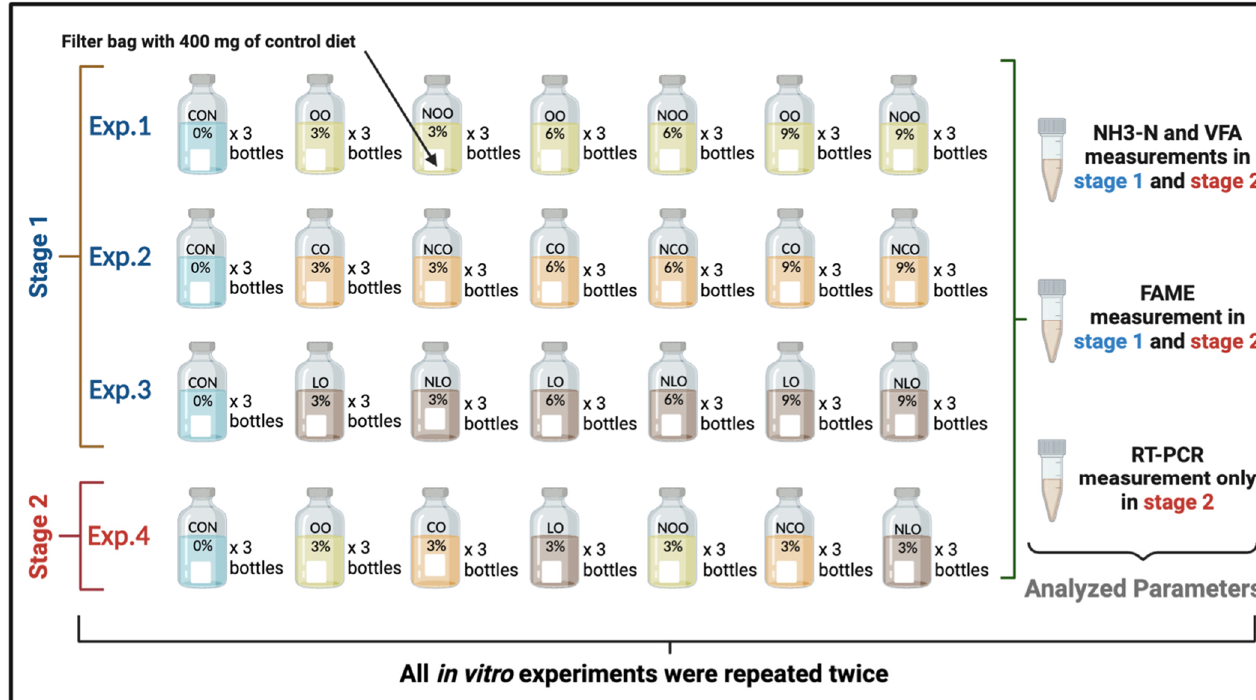
Figure 1. The experimental design and management. The treatments are as follows: CON, control diet; OO, raw olive oil; NOO, nanoemulsified olive oil; CO, raw corn oil; NCO, nanoemulsified corn oil; LO, raw linseed oil; and NLO, nanoemulsified linseed oil.